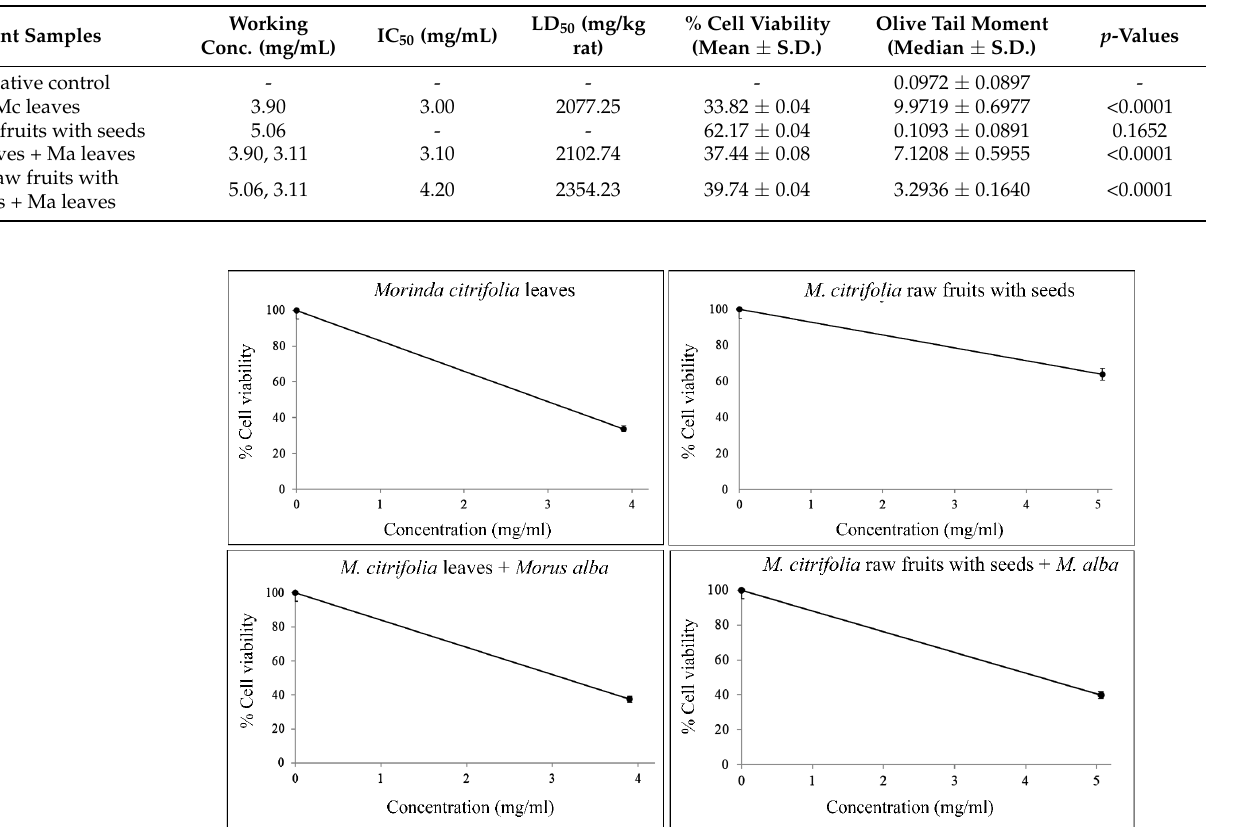
Figure 7. Cytotoxicity showing viability percentages of PBMCs treated with ethanol extracts of Morinda citrifolia leaves, M. citrifolia rawfs, M. citrifolia leaves plus Morus alba and M. citrifolia rawfs plus M. alba extracts.